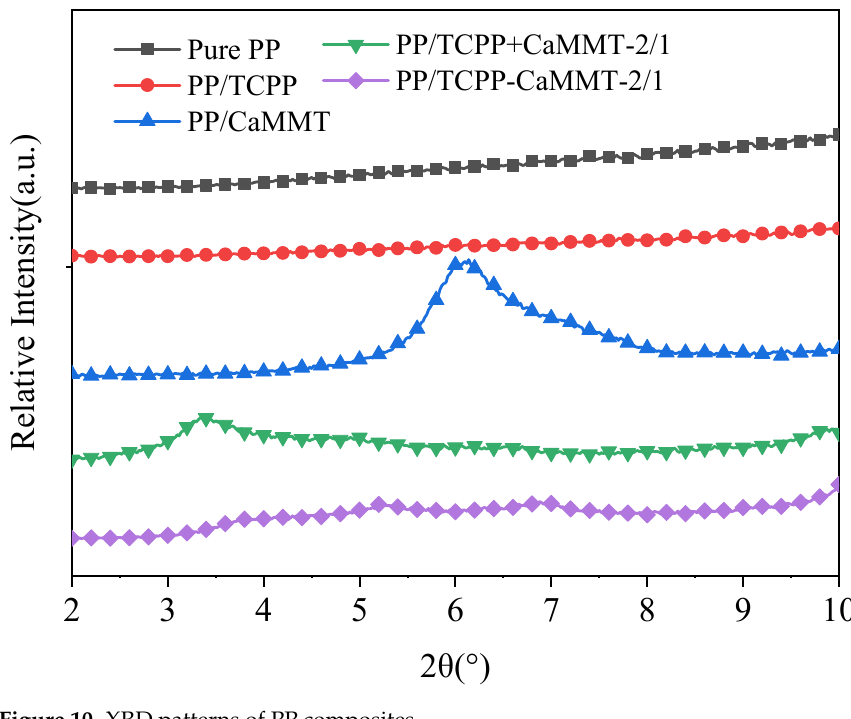
Figure 10. XRD patterns of PP composites.